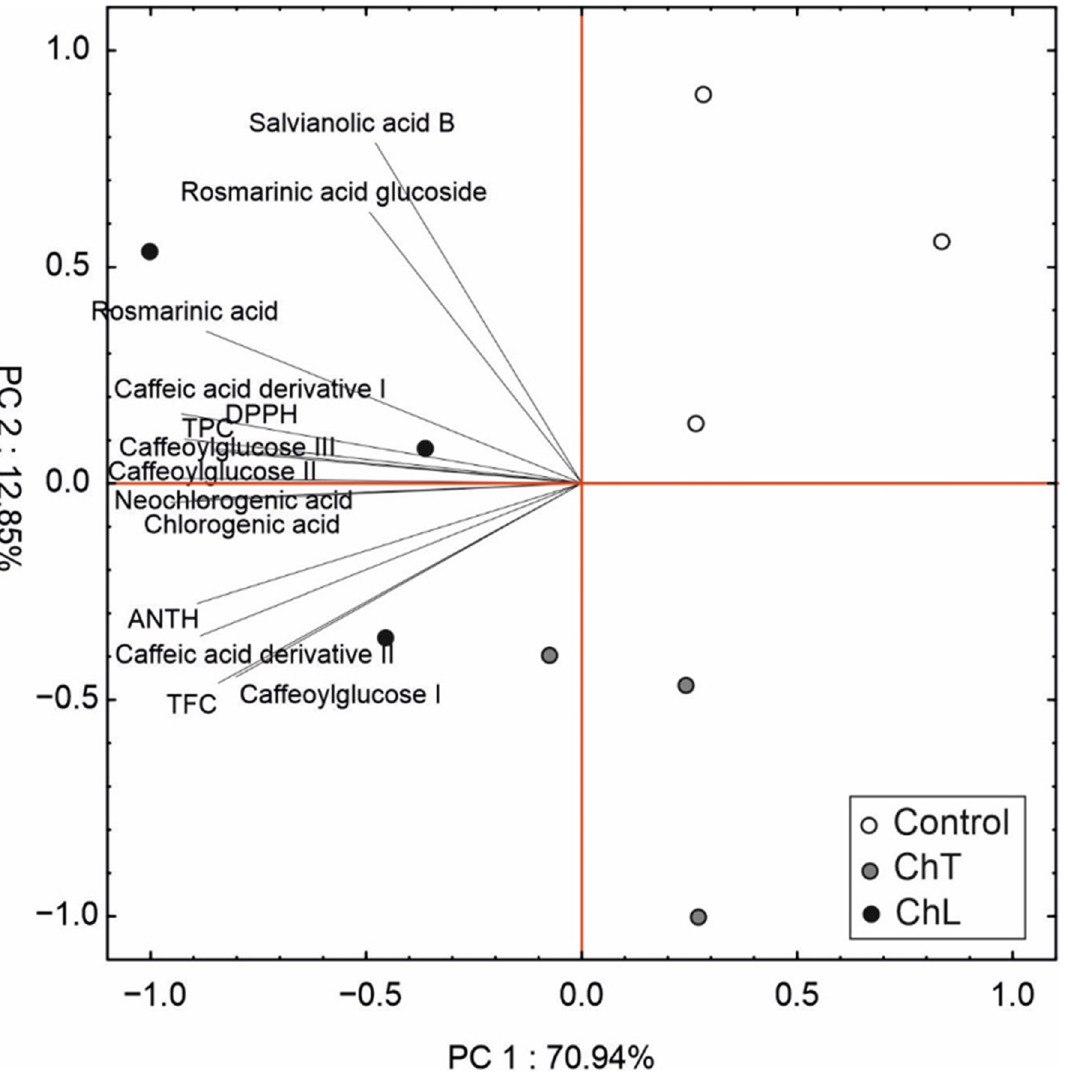
Figure 4. Scaled scatter plot of the principal component analysis (PCA) of selected secondary metabolites and antioxidant capacity (ANTH—anthocyanins; CHT—chitosan suspension, CHL—chitosan lactate, DPPH—antioxidant capacity, TPC—total phenolic content; TFC—total flavonol content). The length of the lines expresses the correlation between the original data and the factor axes. 2.3. Dry Weight of Aboveground Parts and Selected Parameters of Chlorophyll a Fluorescence after Application of Chitosan